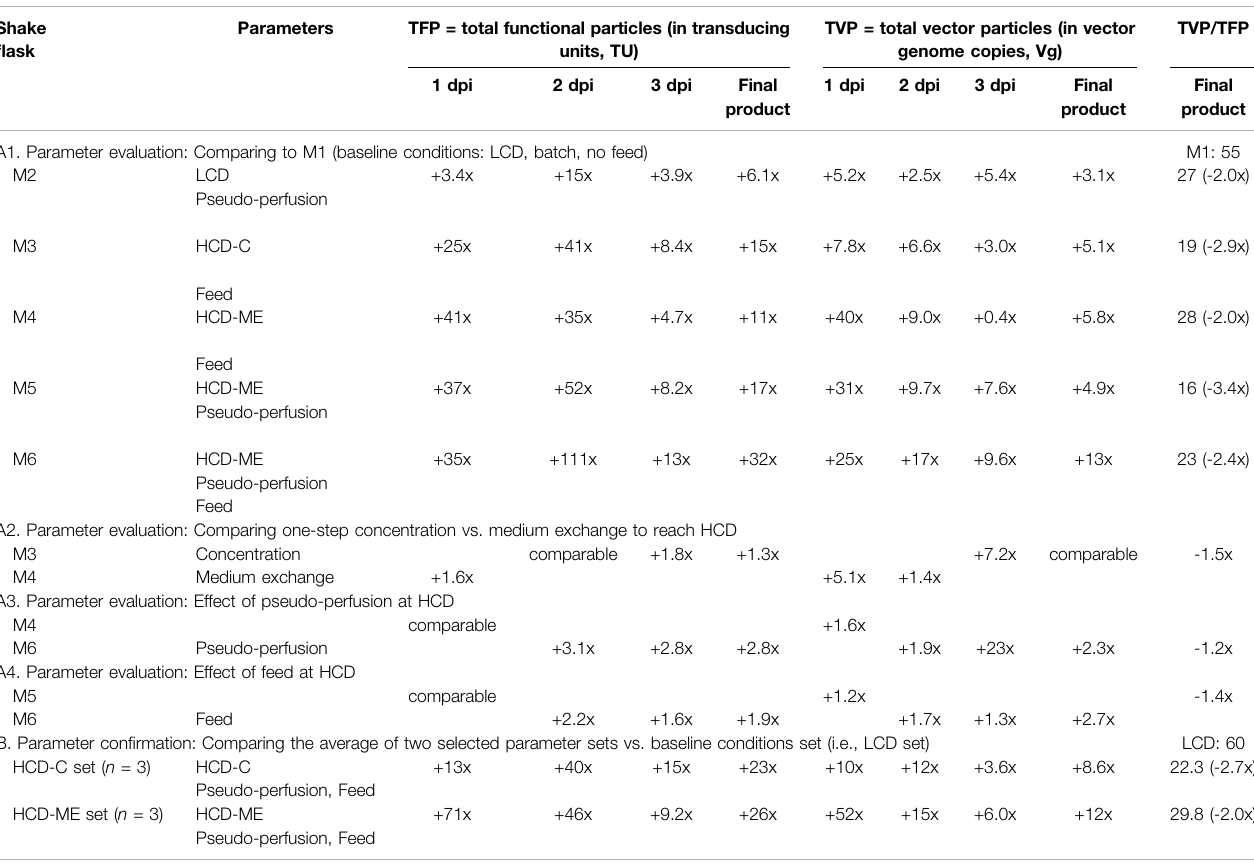
TABLE 1 | Comparison of LV production at shake fl ask scale. Shake fl ask